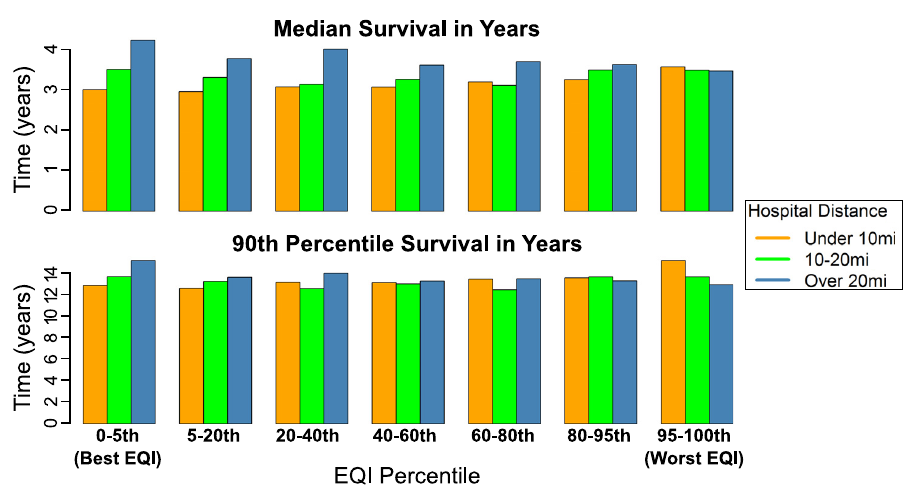
Fig 2. Bar graphs for patient median and 90 th percentile survival for different total EQI domains from the full model separated by average distance to the nearest hospital. Quantile 1 = best EQI, Quantile 7 = worst EQI. Orange = Patients with nearest hospital under 10 miles away, Green = Patients with nearest hospital 10–20 miles away, Blue = Patients with nearest hospital over 20 miles away. Hazard ratios (Table 3) were used with the corrected group prognosis method to generate adjusted survival curves and generate medians/90 th percentile